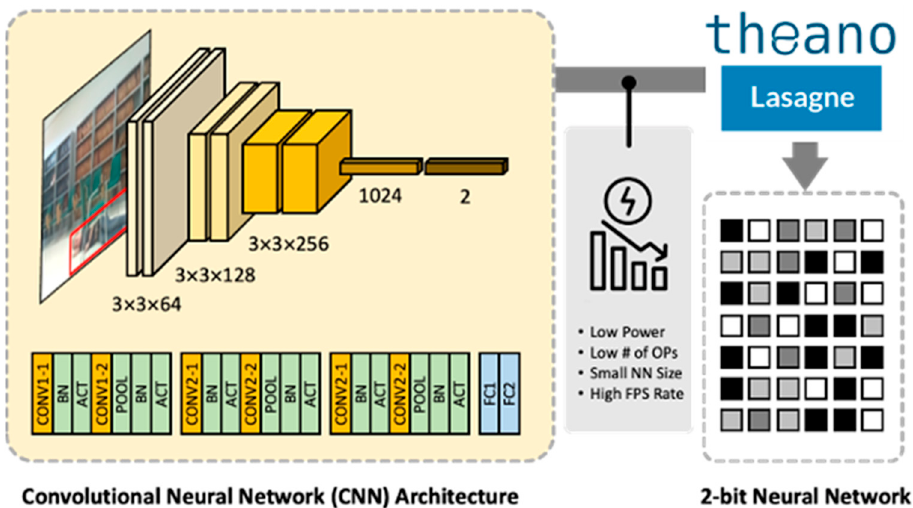
Figure 10. Convolutional neural network architecture.